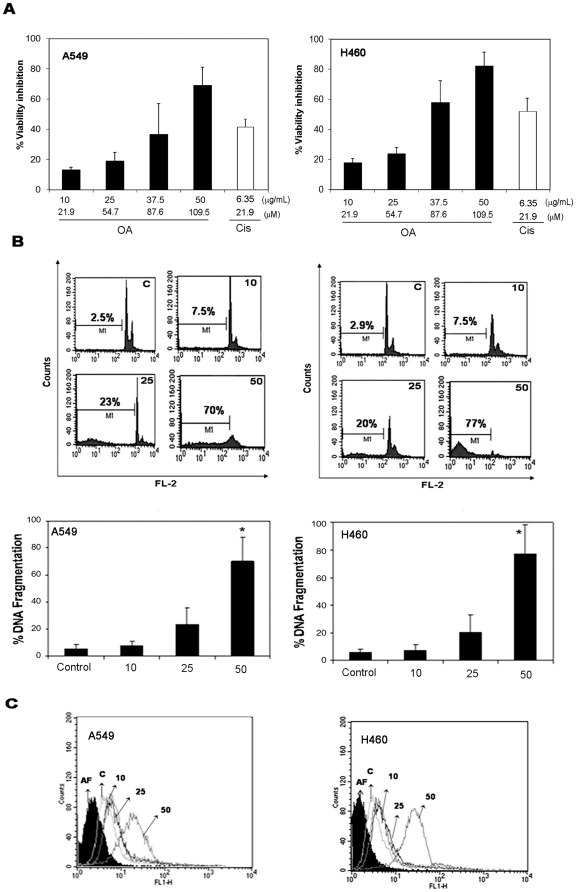
Oleanolic acid (OA) decreases cell viability and induces apoptosis of non-small cell lung cancer cell lines.A549 or H460 cells were incubated with various OA concentrations (10, 25, 40 or 50 µg/mL or 21.9, 54.7, 87.6 or 109.5 µM) or cisplatin for 48 h. (A) Cell viability was assessed by MTT and plotted as percentage of cell viability inhibition. Results represent mean ± SD of 4 experiments performed in triplicate. (B) In parallel, cells were treated with a hypotonic solution containing propidium iodide (PI) and DNA-content was analyzed by flow cytometry. Upper panel: representative histogram of the cell cycle. Lower panel: percentage of apoptotic sub-G1 cells. Values represent mean ± SD of 3 experiments performed in triplicate. (C) Caspase-3 activated cells was determined by flow cytometry using a CaspGlow kit as described in M&M. Histograms are representative of two independent experiments performed in duplicate.